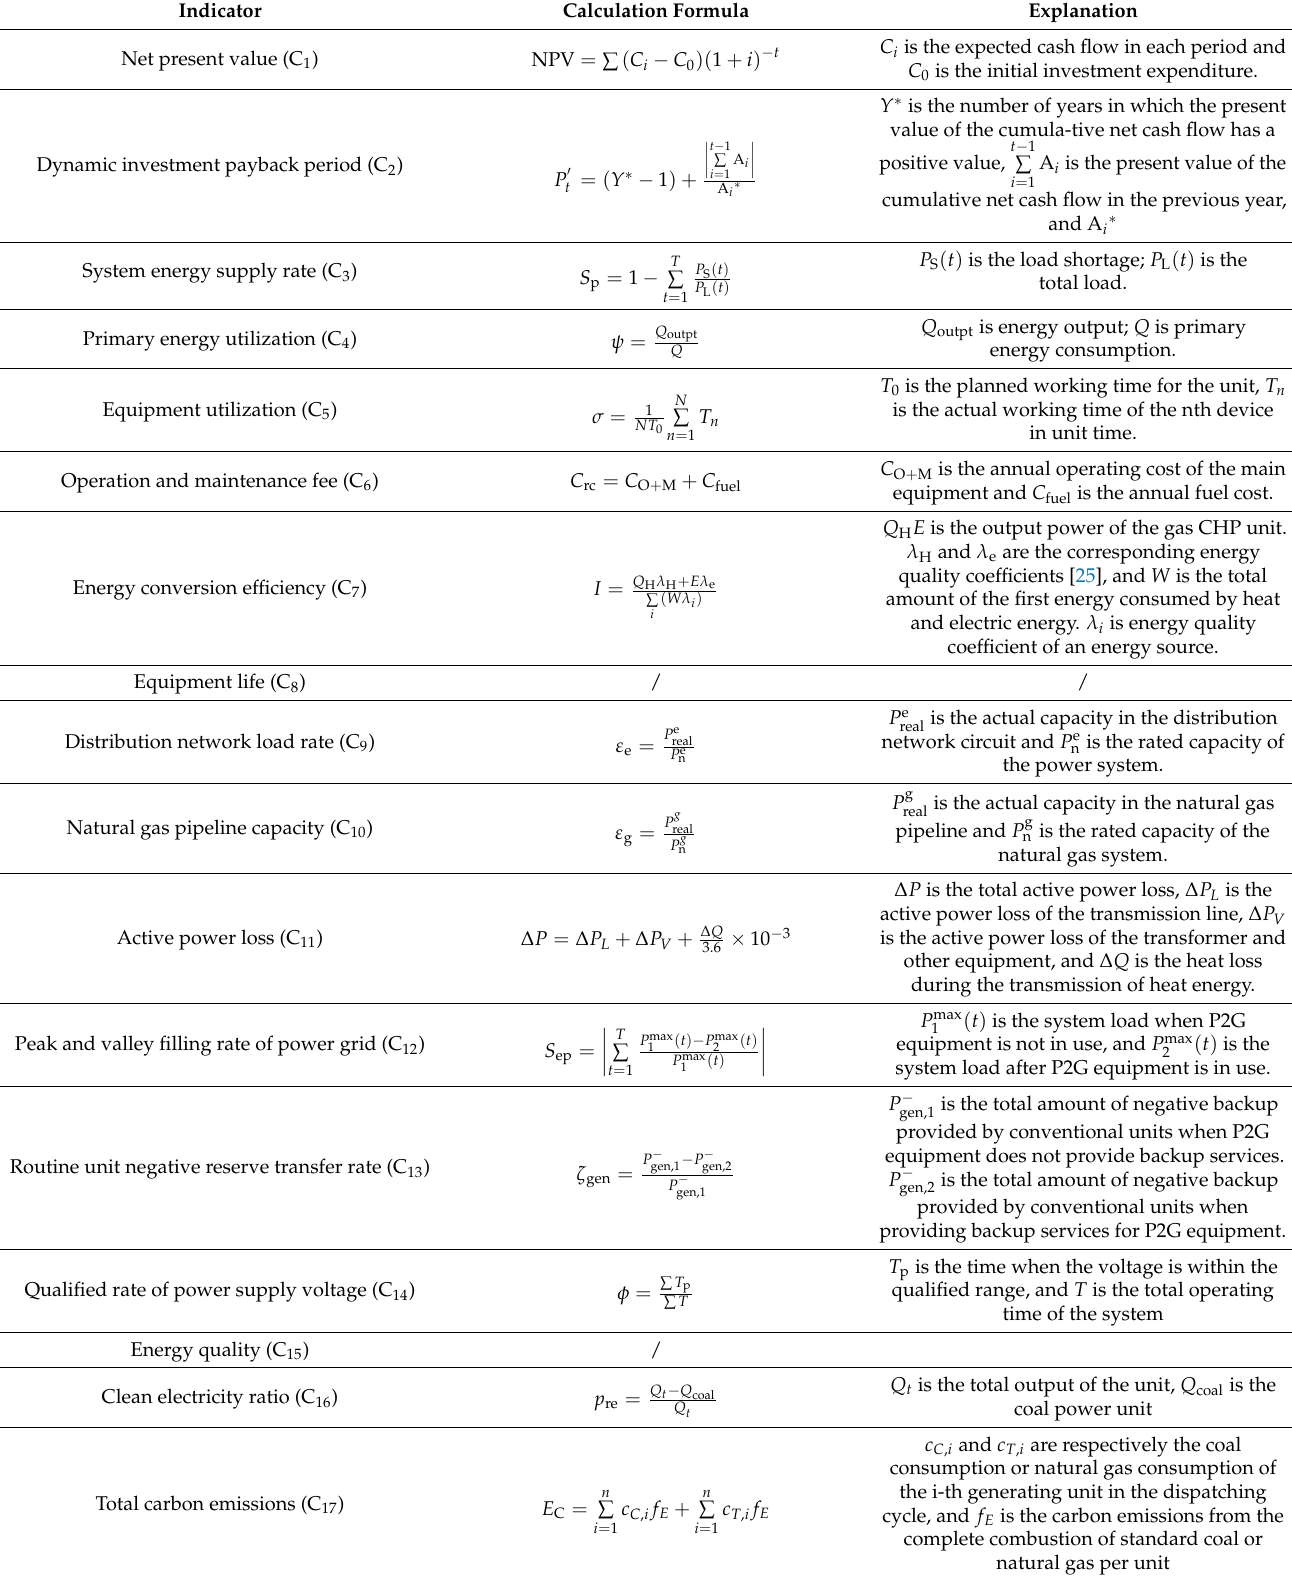
Table A1. Explanation of comprehensive benefit evaluation indicator system of the